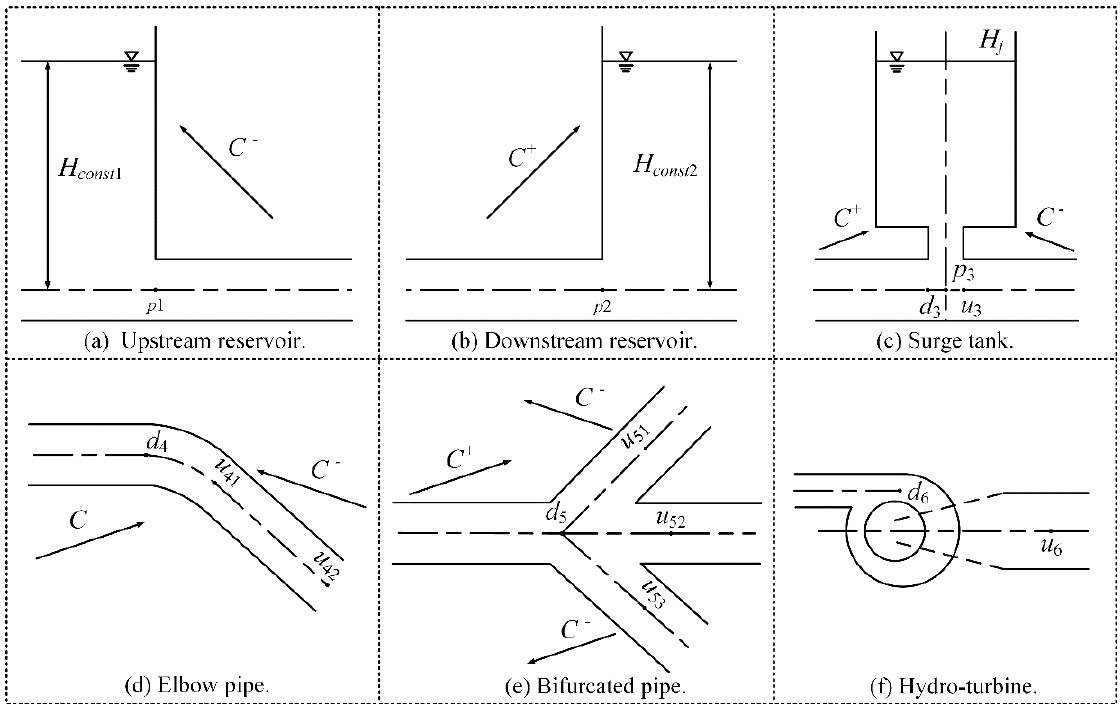
Figure 4. The schematic diagram of boundary conditions for each node of the WDS.